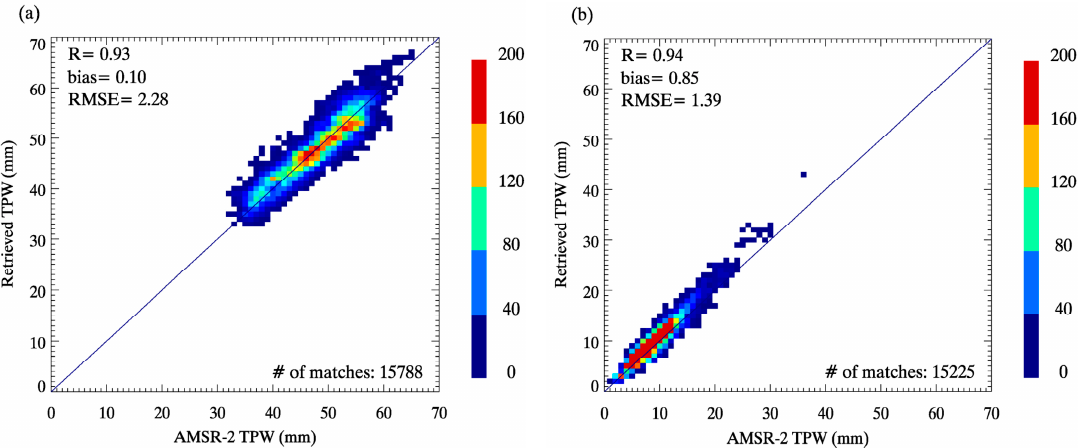
Figure 14 Figure 14. Comparison results of retrieved TPW and AMSR-2 measurements over the region between 30–45N and 120–145E for ( a ) summer and ( b )